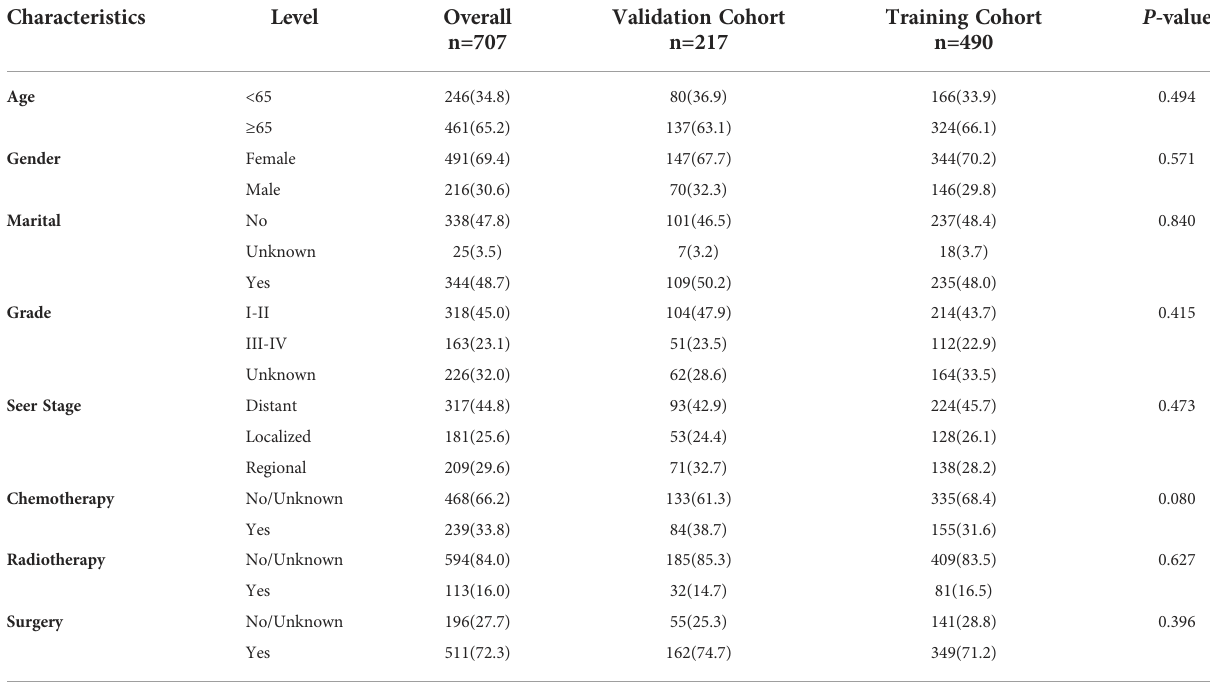
TABLE 1 Clinicopathological characteristics of patients with